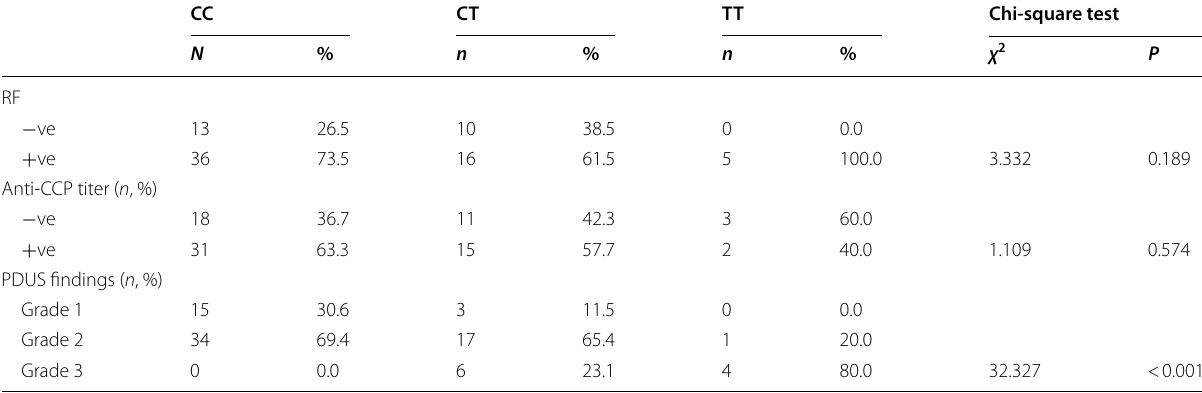
Level of significance at P